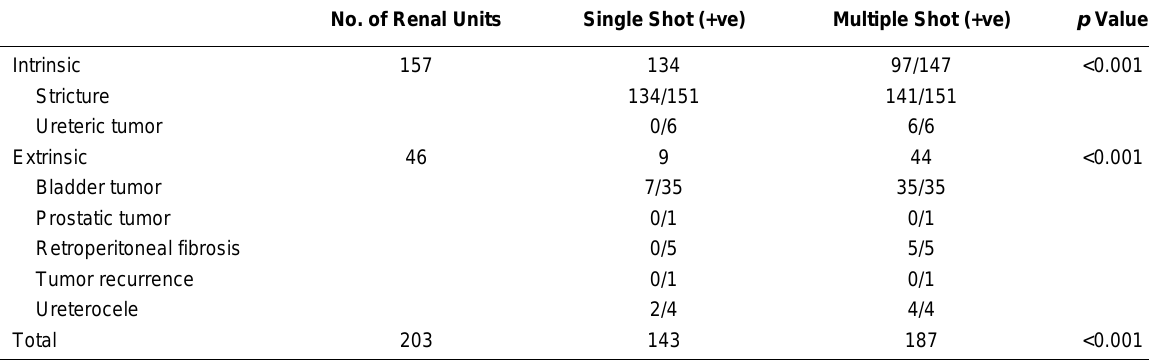
Comparison between Single-Shot and Standard MRU in Diagnosis of Noncalcular Urinary